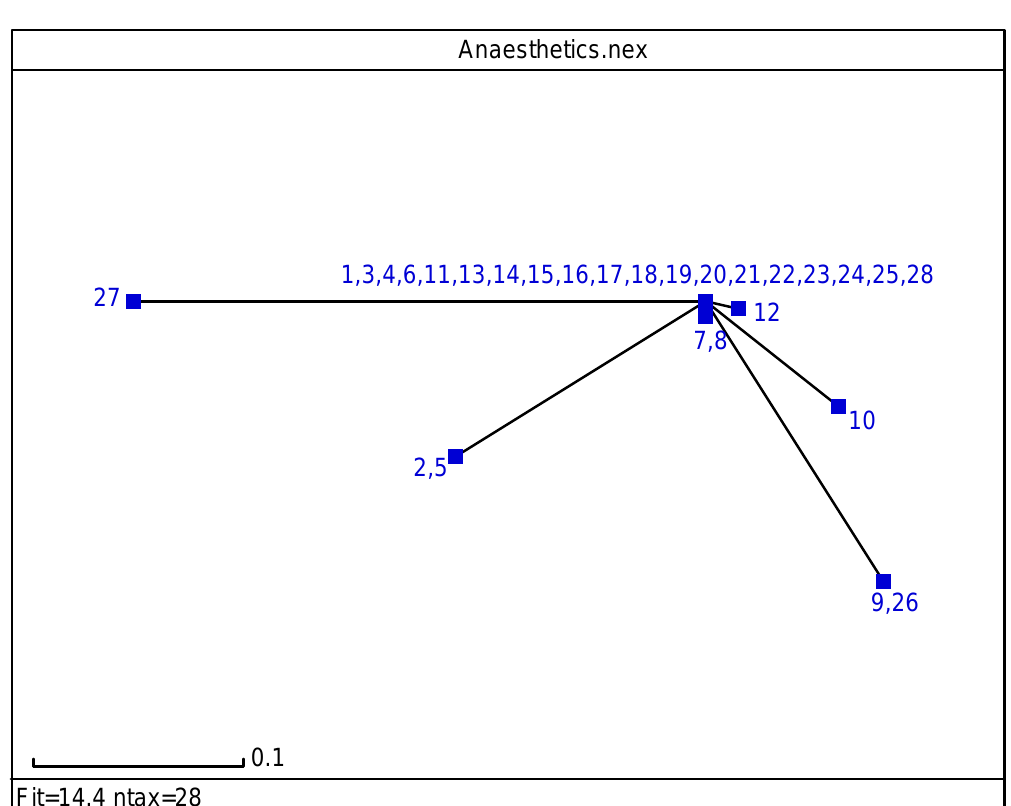
Figure 7. Splits graph for the local anaesthetics analogues of procaine.